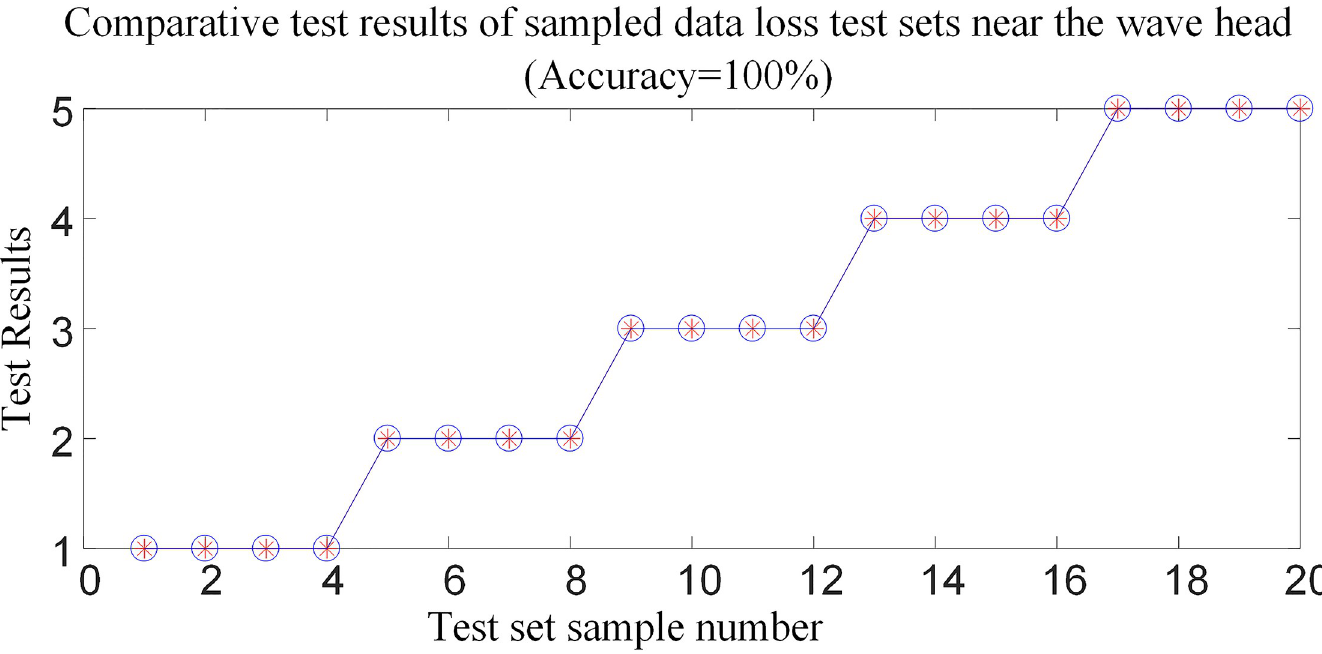
Fig 18. Sample data loss near the traveling wave head (10~40 data) recognition result.